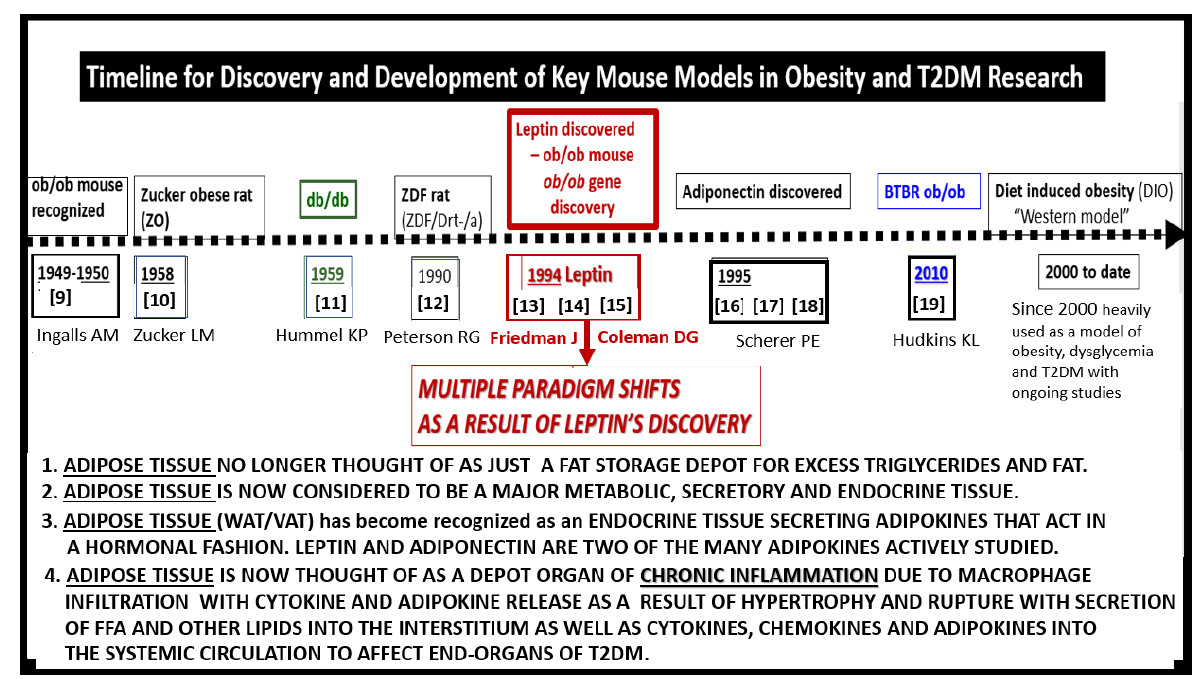
Figure 1 . Timeline for discovery and development of key mouse models in obesity and Type 2 diabetes mellitus (T2DM) research. The dashed timeline illustrates important discoveries and models from 1949 to date. References are inserted below the dates of each model. The central importance of leptin is emphasized. FFA = free fatty acids; VAT = visceral adipose tissue; WAT = white adipose tissue.